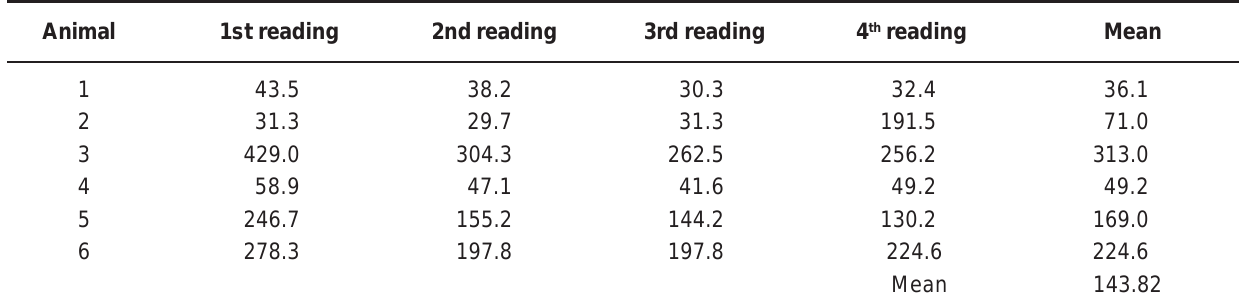
TABLE 1 - Mean nitric oxide release in µ mols of Sealer 26 cement in peritoneal macrophage culture obtained from six Swiss